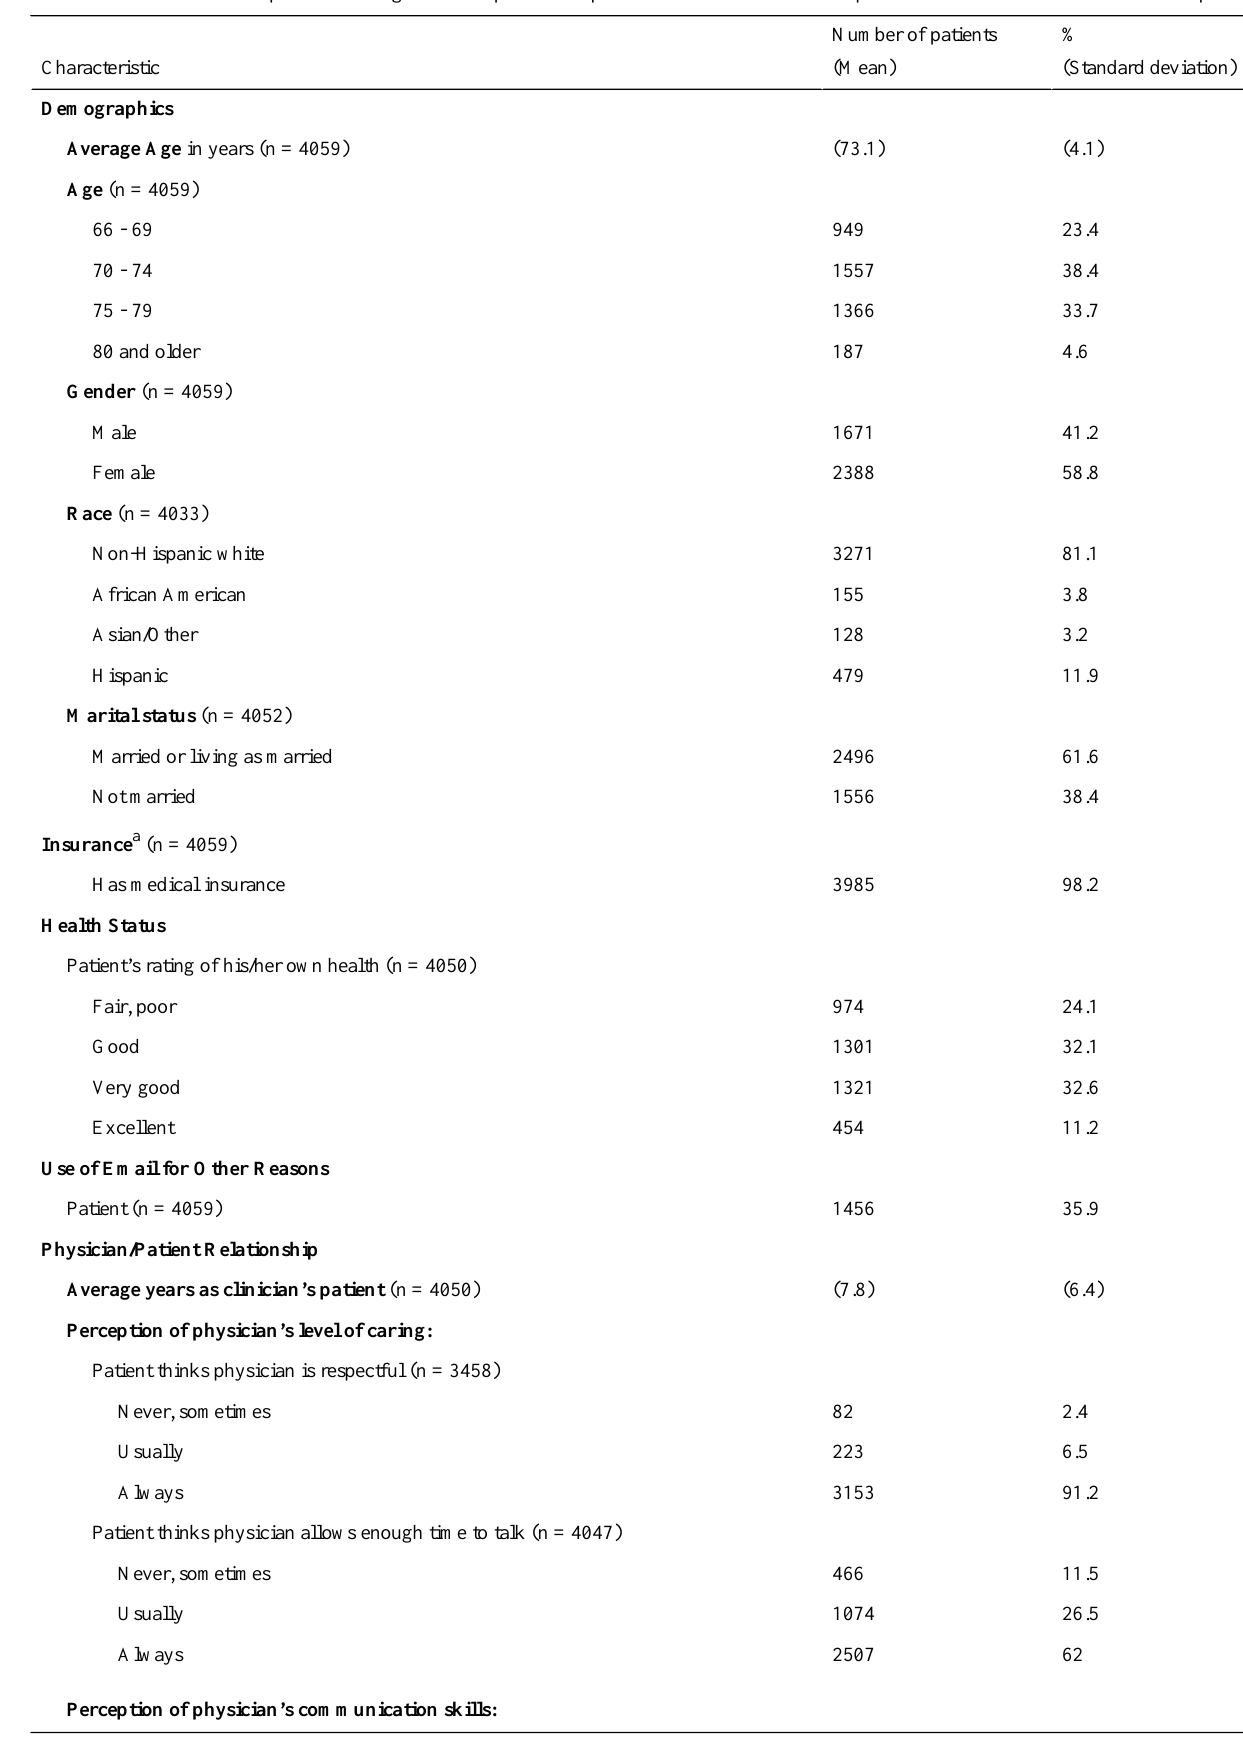
Table 1. Characteristics of patients over age 65 in the pooled sample from the 2003 CMC 2 exit questionnaire and 2003 CMC 3 baseline